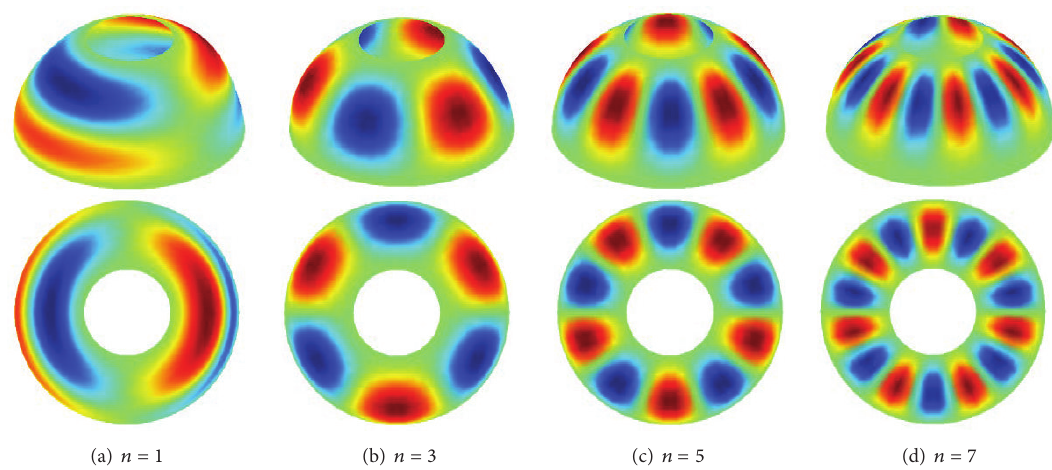
Figure 12: Several selected mode shapes for closed spherical shells with different wavenumbers subjected to E 3 -E 3 (𝑚 = 1)